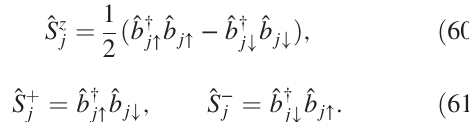
ˆ F 1 /2 Þ , the N´eel ij ð ˆ F S Þ exchanges ij ð